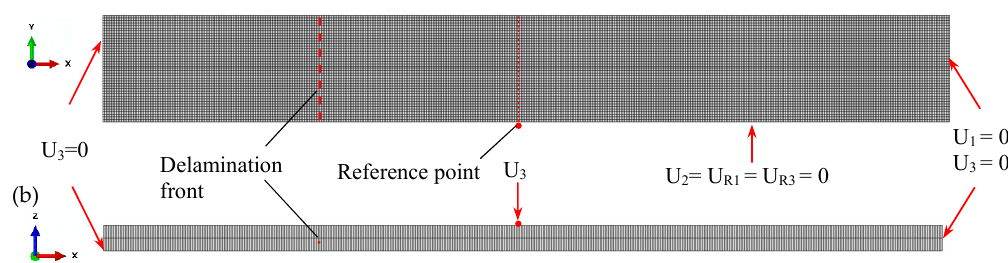
Figure 5. Model for simulating Mode II experiment: ( a ) top view; ( b ) front view. Figure 5. FE model for simulating Mode II experiment: ( a ) top view; ( b ) front